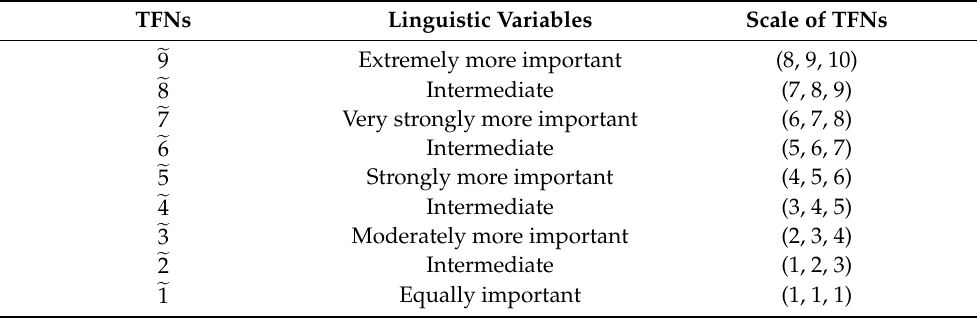
Table 1. Linguistic variables and corresponding TFNs (triangular fuzzy numbers).